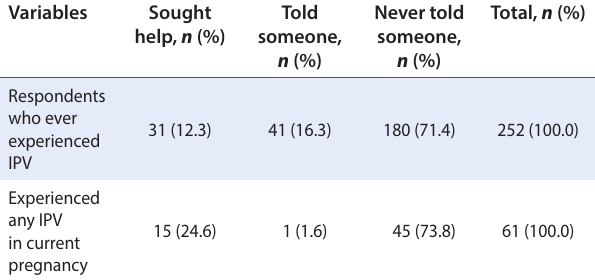
Table 5: Distribution of respondents who sought help Variables Sought help, n (%)